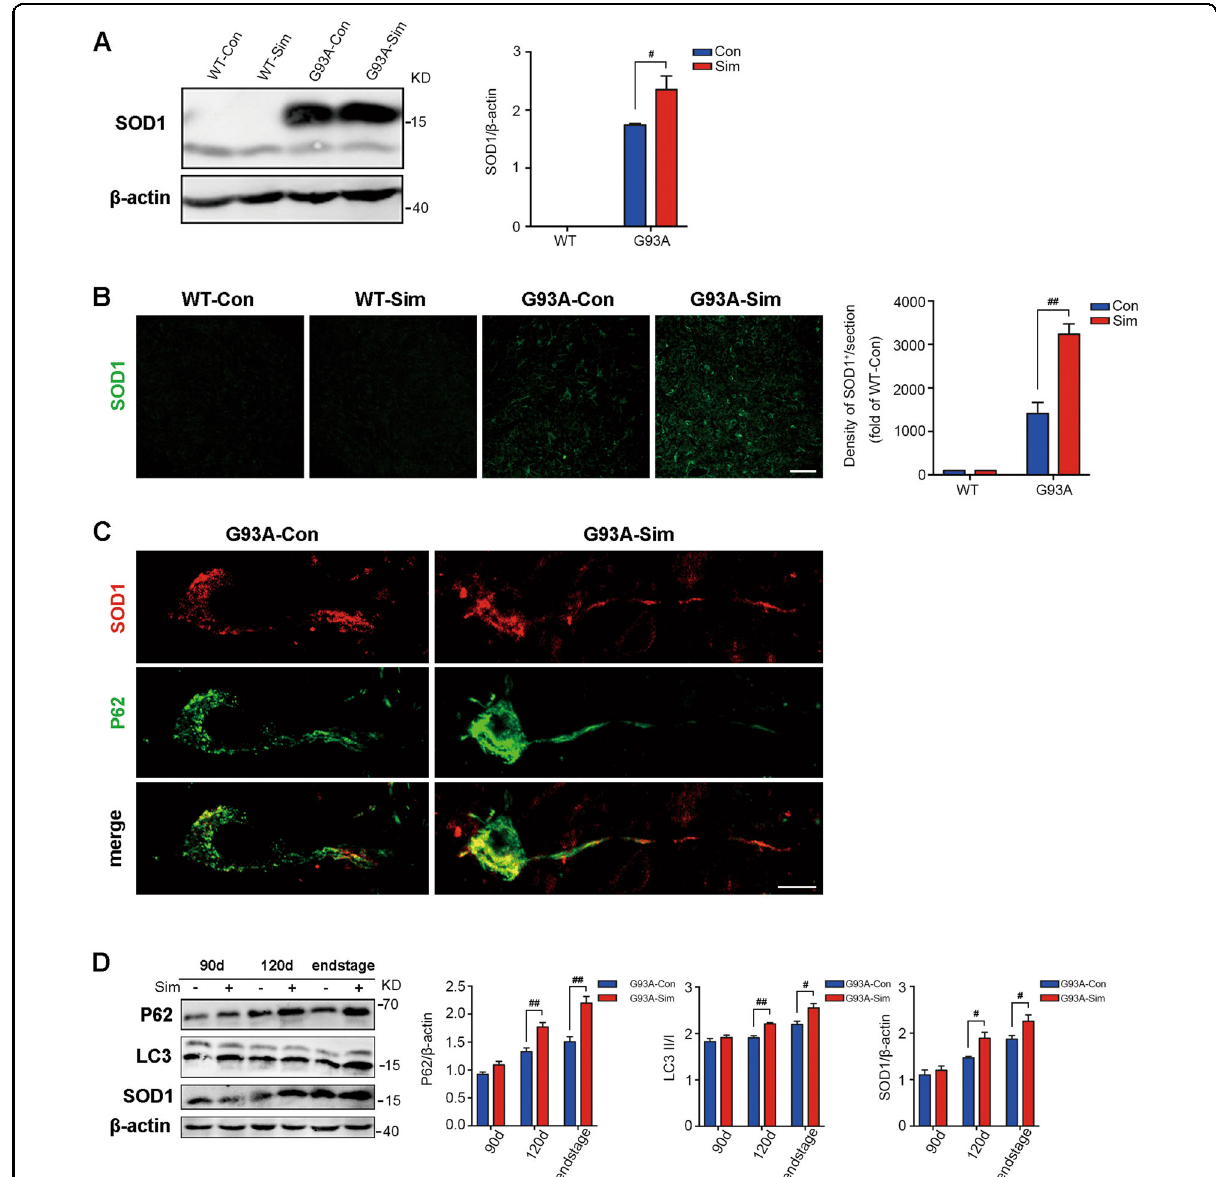
Fig. 2 Simvastatin increased SOD1 aggregation in SOD1 G93A mice. A Western blot analysis of SOD1 levels in the lumbar spinal cord at 120 days. Quantitative analysis of SOD1 levels. B Immuno fl uorescence labeling of SOD1 (green) in the lumbar spinal cord at 120 days (Scale bars, 50 μ m). Quanti fi cation of SOD1 immunoreactivity. C Colocalization of SOD1 (red) and P62 (green) in MNs of G93A-Sim and G93A-Con mice at 120 days (Scale bars, 10 μ m). D Representative Western blot quanti fi cation of P62, LC3, and SOD1 levels in the lumbar spinal cord of G93A-Sim and G93A-Con mice at 90 days, 120 days, and end-stage of disease. (Data represent the mean ± SEM, n = 5 mice per group; statistical signi fi cance was assessed by one-way ANOVA or an unpaired t -test, # P ≤ 0.05, ## P ≤ 0.01, ### P ≤